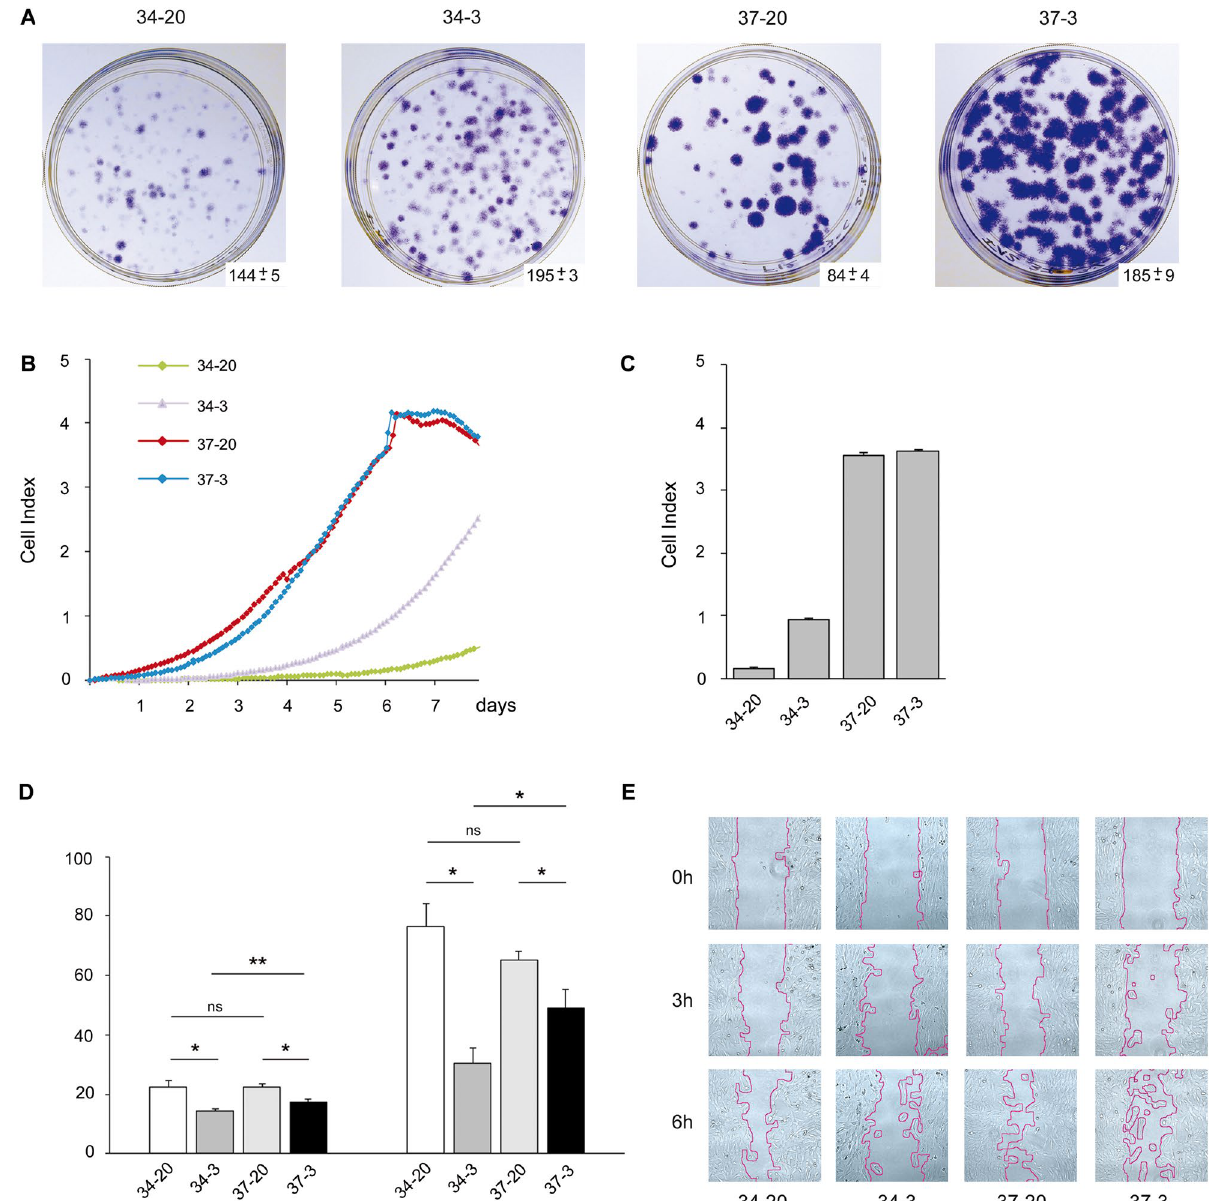
Figure 5. Effects of temperature and oxygen tension on hFOB properties. ( A ) hFOB cells were seeded at a density of 10 cells/cm 2 and allowed to form colonies for 15 days at 34 °C/20% O 2 (34–20); 34 °C/3% O 2 (34–3); 37 °C/20% O 2 (37–20) and 37 °C/3% O 2 (37–3). After fixation and staining with crystal violet, colonies were counted and depicted as mean ± standard deviation (n = 3). B) hFOBs were seeded at a density of 2 × 10 2 /cm 2 in each well of an impedance reader E-plate and cell growth was non-invasively monitored every 2 h over a time lapse of 8 days. Impedance was expressed as a Cell Index (CI) value. Representative graph from xCELLigence system are shown for growth curves of hFOB cultured at specified temperature and oxygen conditions. ( C ) CI-values were compared at 6 days after seeding. ( D ) Cell wounding and assessment of migratory behavior of hFOB at passages 5–7 at various culture conditions. Quantitative image data acquisition was performed with Live Cell Imager CELL IQ and analysis was performed with CellActivision Software (Yokogama). Results for quantitative analysis of percentage of gap closure at the different culture conditions are shown for 3 h and 6 h after gap opening. ( E ) Representative images at given conditions are shown. Gap closures are highlighted at 0 h, 3 h and 6 h after gap opening with pink